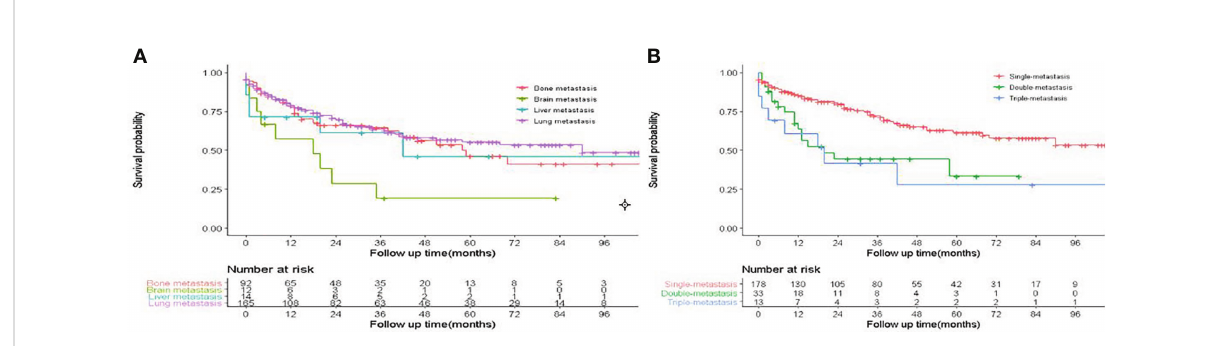
FIGURE 2 Effect of distant metastasis on overall survival in FDTCs. (A) The overall survival in different metastasis sites. (B) The overall survival of different metastasis patterns.